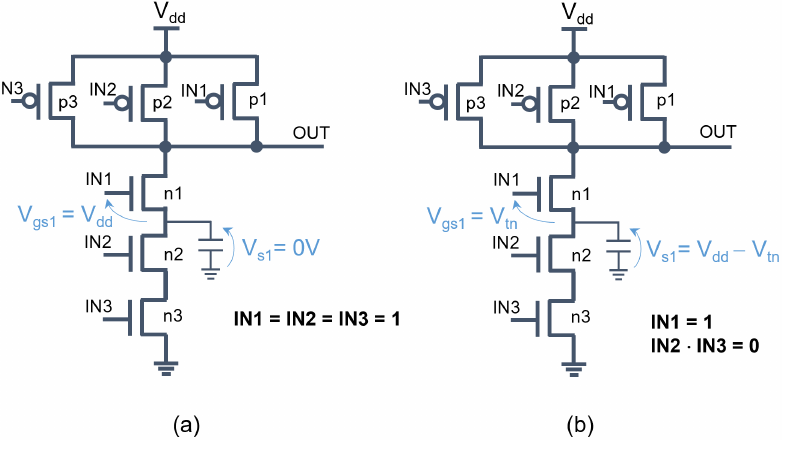
Figure 1. A 3-in NAND gate: ( a ) transistor n1 is under stress; ( b ) transistor n1 is not under